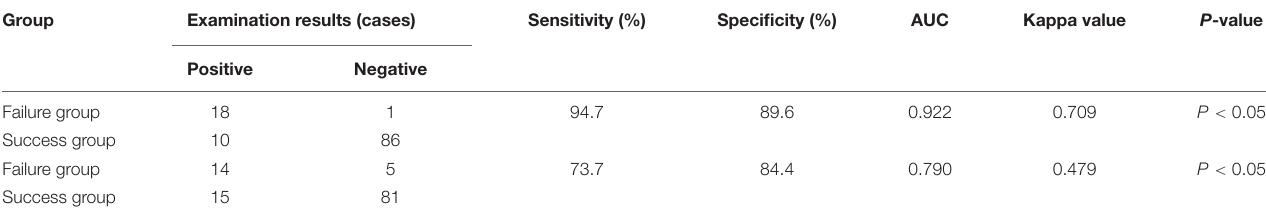
TABLE 2 | Comparison of the consistencies of the pulmonary ultrasound and chest X-ray (CXR) findings and the actual results of ventilation weaning.